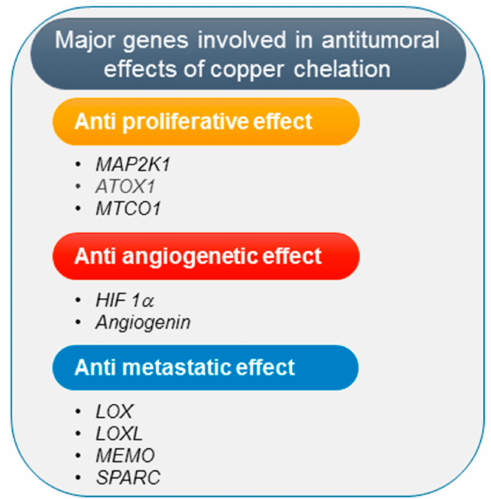
Figure 1. Schematic representation of the main genes involved in the antitumoral e ff ects of copper chelation therapy